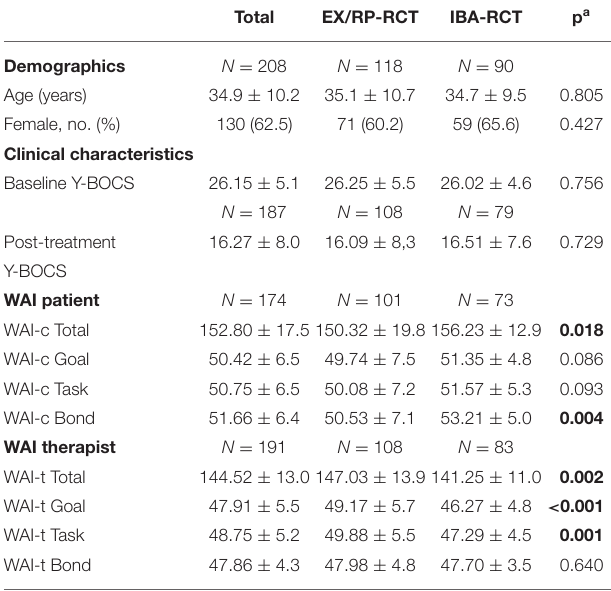
TABLE 1 | Demographic and clinical characteristics of the study